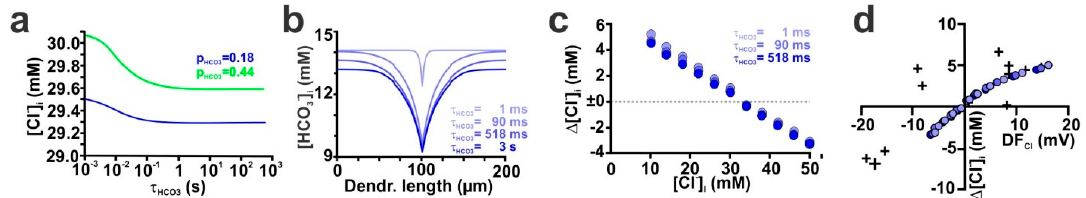
Figure 7. Influence of the stability of HCO3 ⁻ gradients (via variations in τ HCO3 ) on GABA-induced